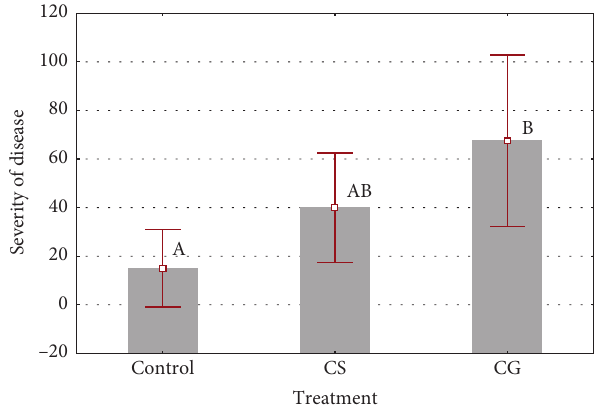
Figure 2: Infection severity of control fruits and fruits treated with Colletotrichum siamense (CS) and Colletotrichum gloeosporioides